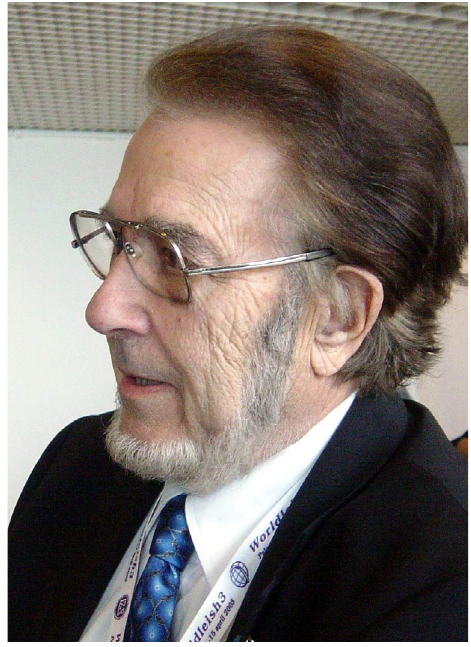
Figure 1. Professor Jean-Antoine Rioux